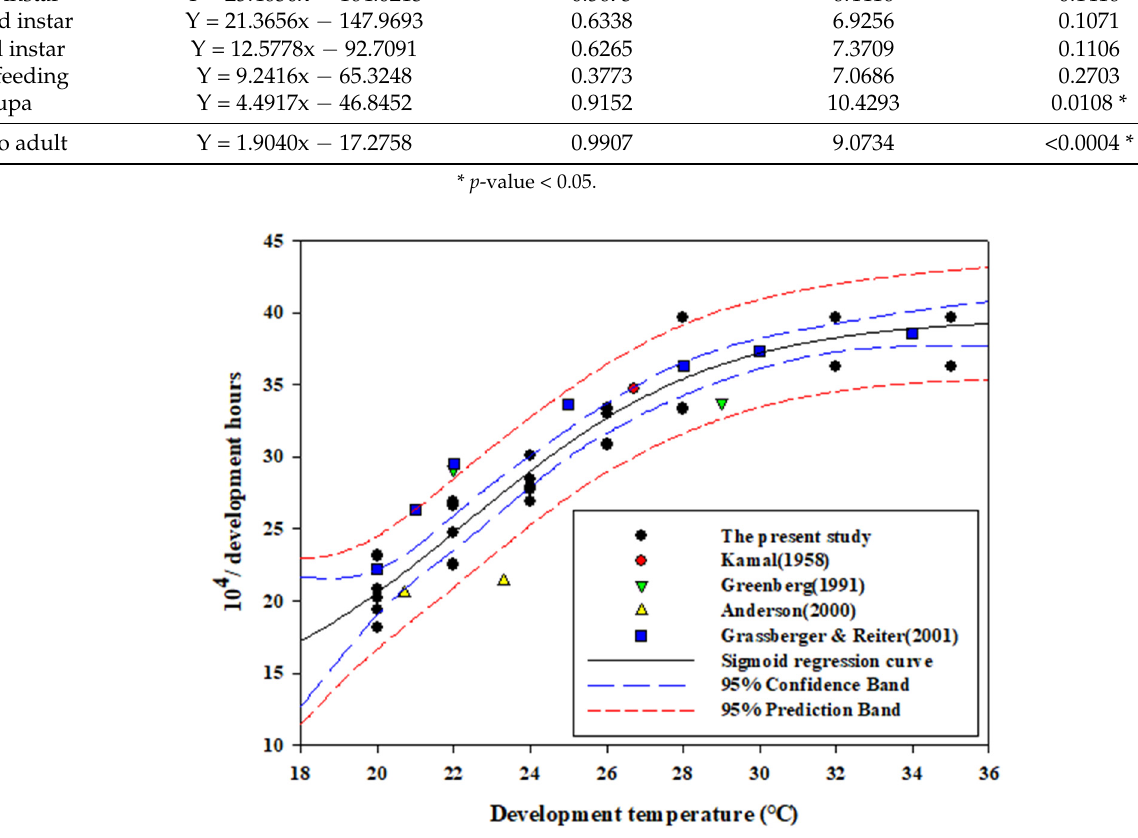
Figure 3. Four-parameter sigmoid model for the growth rate of Lucilia sericata from eggs to adults at five temperature regimes with 95% confidence and 95% prediction intervals. Although rearing was duplicated five times at seven temperatures, the dots of the present study overlapped due to similar results. Data from most previous studies fell within the 95% prediction